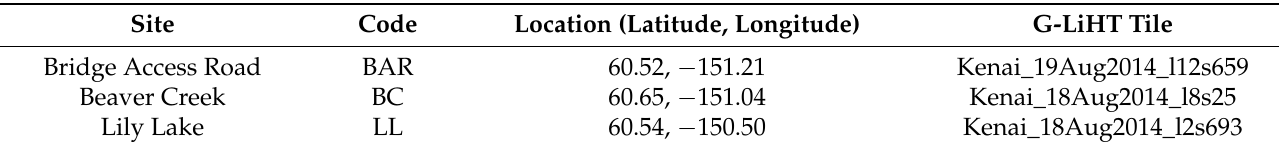
Table 1. Site locations and corresponding G-LiHT